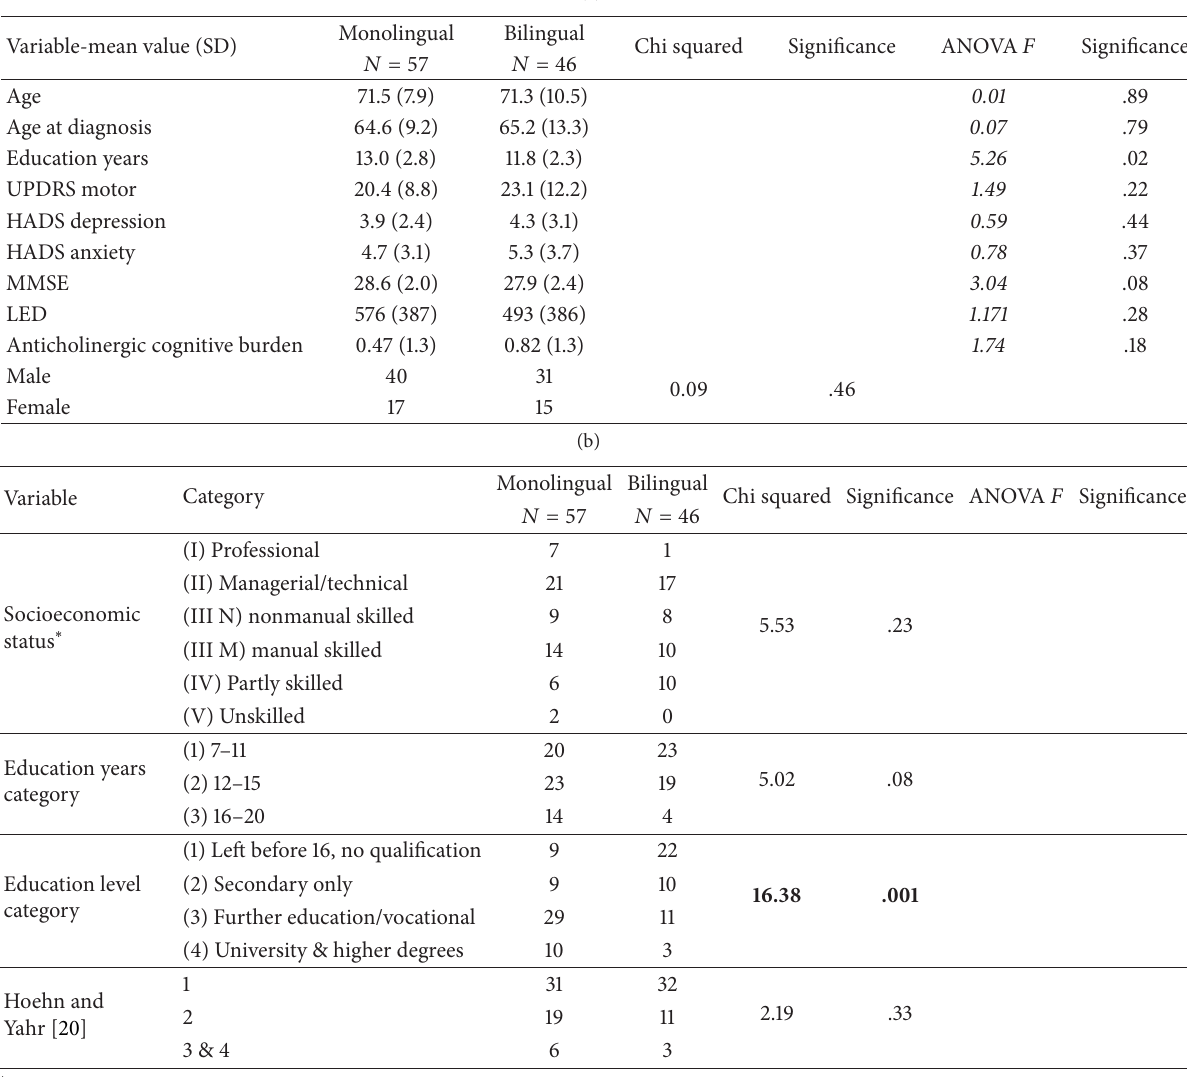
Table 1: Baseline demographics and disease